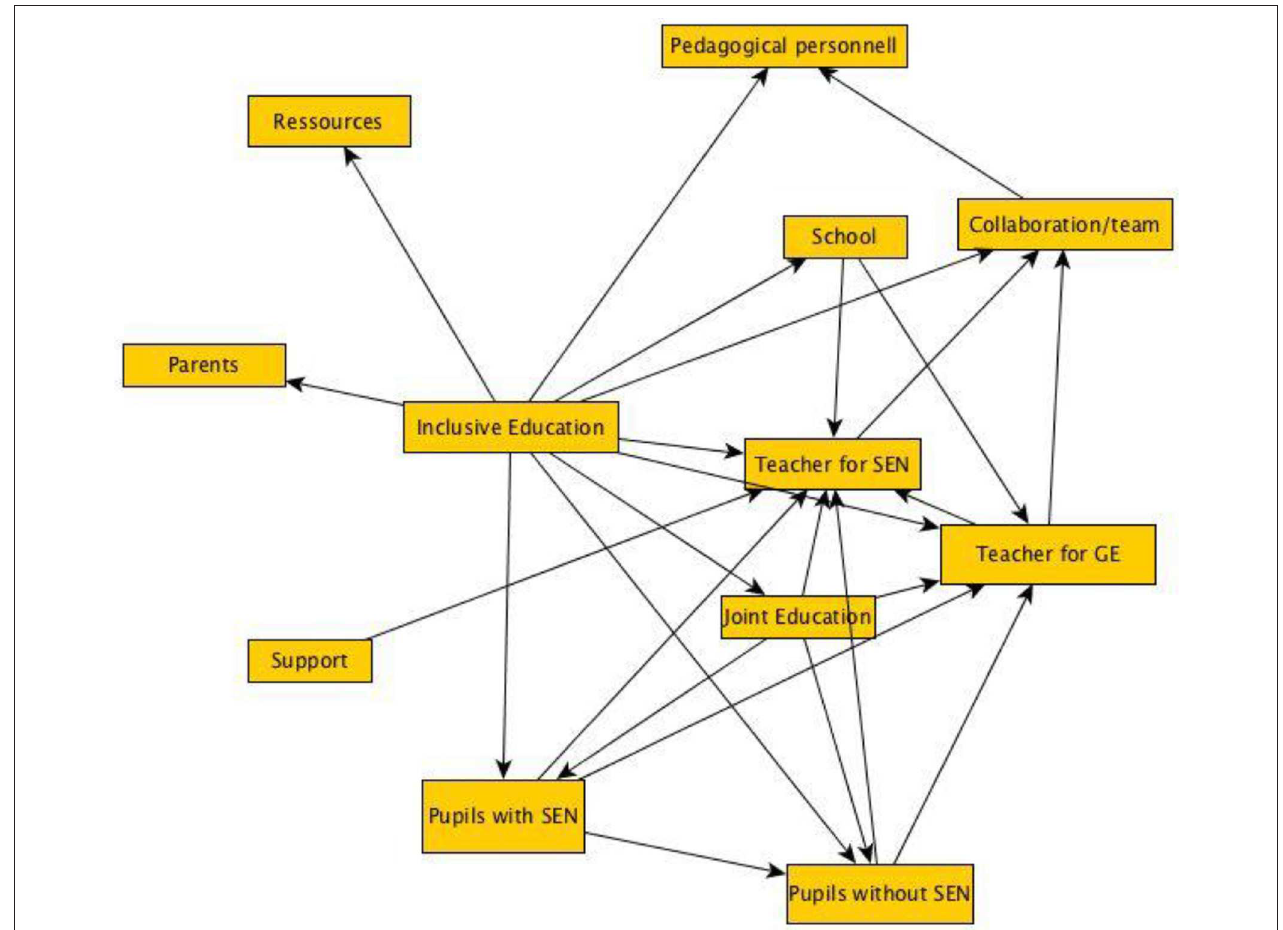
FIGURE 4 | Pathfinder network of participants in mono-professional teams at t2 ( N =